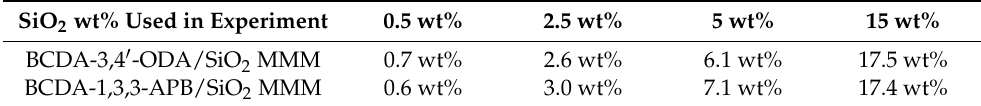
Table 1. Values of actual SiO 2 .wt% in alicyclic PI/SiO 2 MMMs obtained from